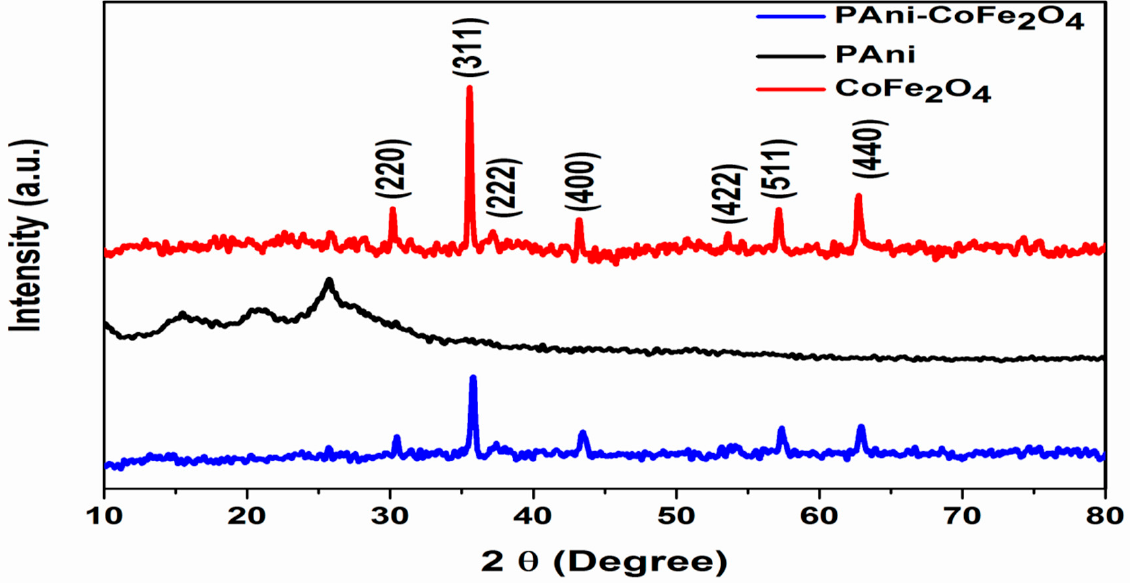
Figure 5. The XRD of CoFe 2 O 4 , PAni and nanocomposite of PAni-CoFe 2 O 4 (50%).